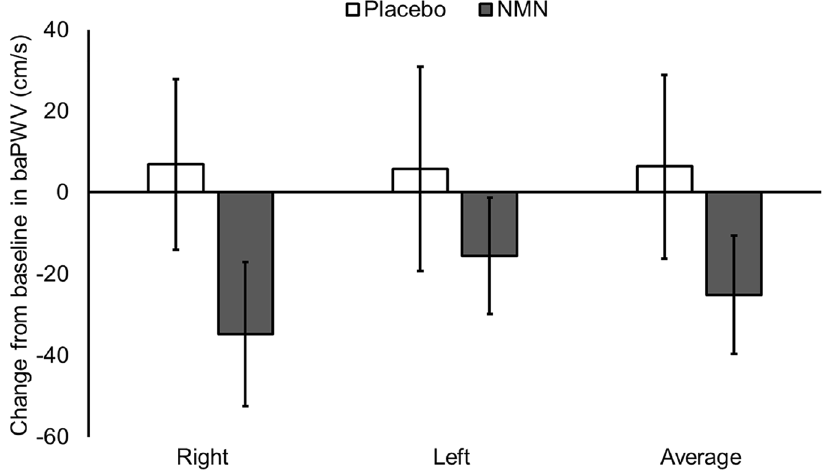
Figure 2. Change from baseline in brachial-ankle pulse wave velocity (baPWV) after nicotinamide mononucleotide (NMN) or placebo supplementation. Values are expressed as mean ± standard error.